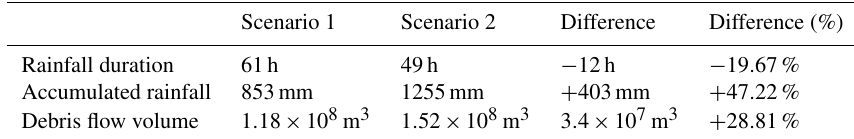
Table 4. Comparison of rainfall and debris flow